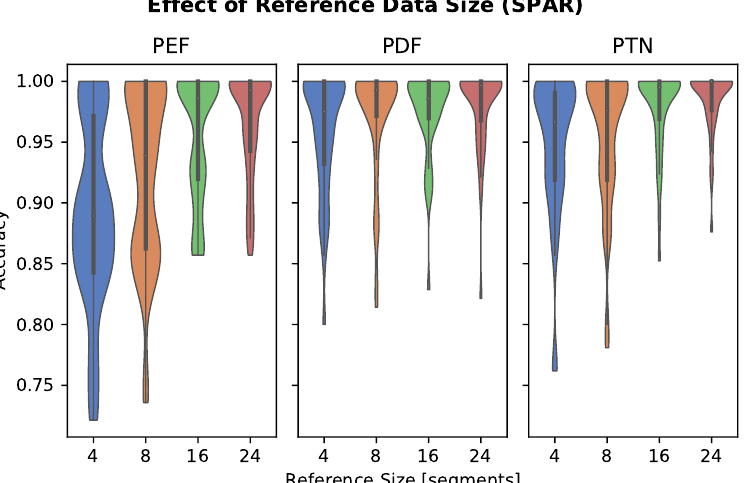
Figure 4. The effect of reference data size (number of reference segments per activity class) on personalized feature classifier accuracy, evaluated on the SPAR dataset. Increasing reference data size results in improved performance for the PEF model. A reference size of four segments results in significantly degraded performance in all